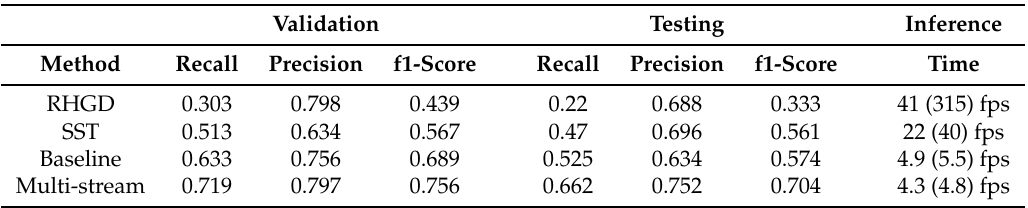
Table 6. Detailed comparison of gesture recognition results based on temporal proposals of our multi-stream approach and previous works.